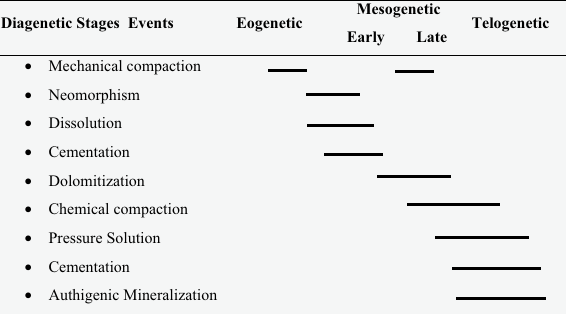
Fig. 10 General paragenetic sequence of Chia Gara Formation in studied